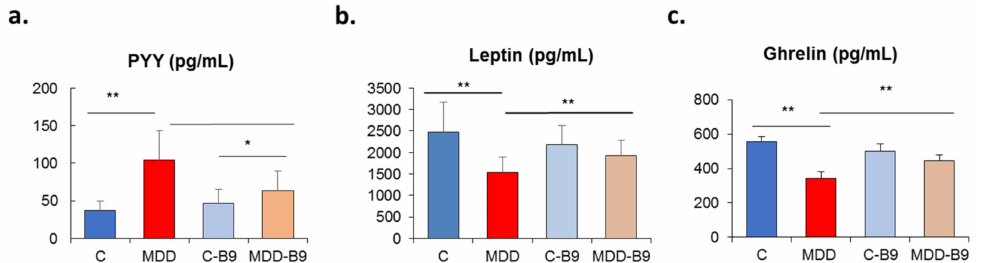
Figure 3. E ff ects of methyl donor deficiency on plasma concentrations of peripheral hormones rat pups at 21 days of age, and e ff ects of folate supplementation. ( a ) Peptide YY (PYY); ( b ) leptin; ( c ) ghrelin. Data are means ± SD from six individuals per group. Statistically significant di ff erences between the di ff erent animal groups: * p < 0.05 and ** p < 0.01.